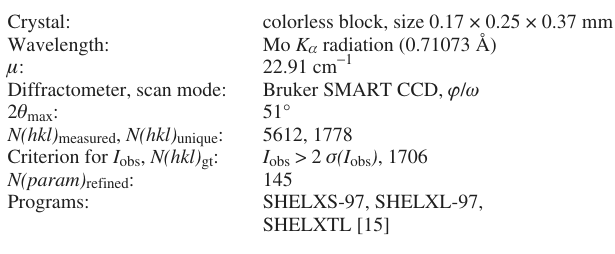
Table 1. Data collection and